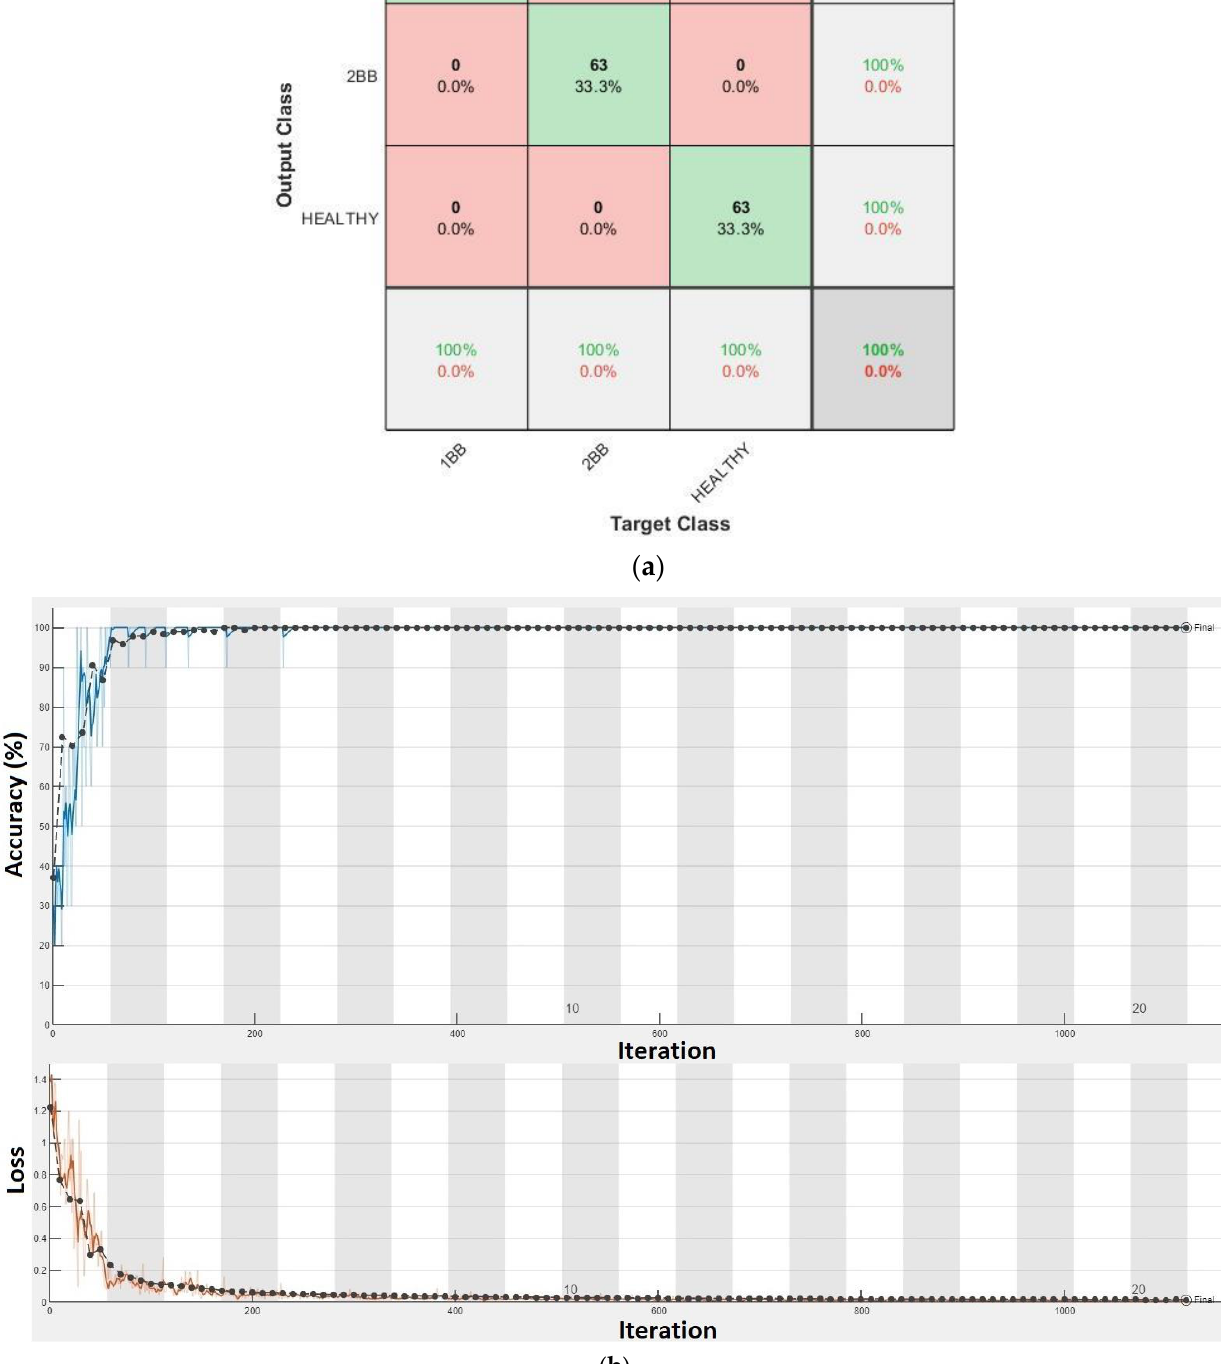
Figure 16. Results for ABB soft starter: ( a ) Confusion matrix. ( b ) Training progress. For the case of the SIEMENS model, 756 (252 samples per category) training samples were used to train the CNN and 252 different samples (84 samples per category) were used for the validation. In Figure 17, it can be observed that the accuracy of the CNN also in this case reaches 100%. In addition, the training process reaches 100% accuracy after about 68 iterations, in epoch one. Moreover, it becomes stable at 100% after, more or less, 160 iterations.